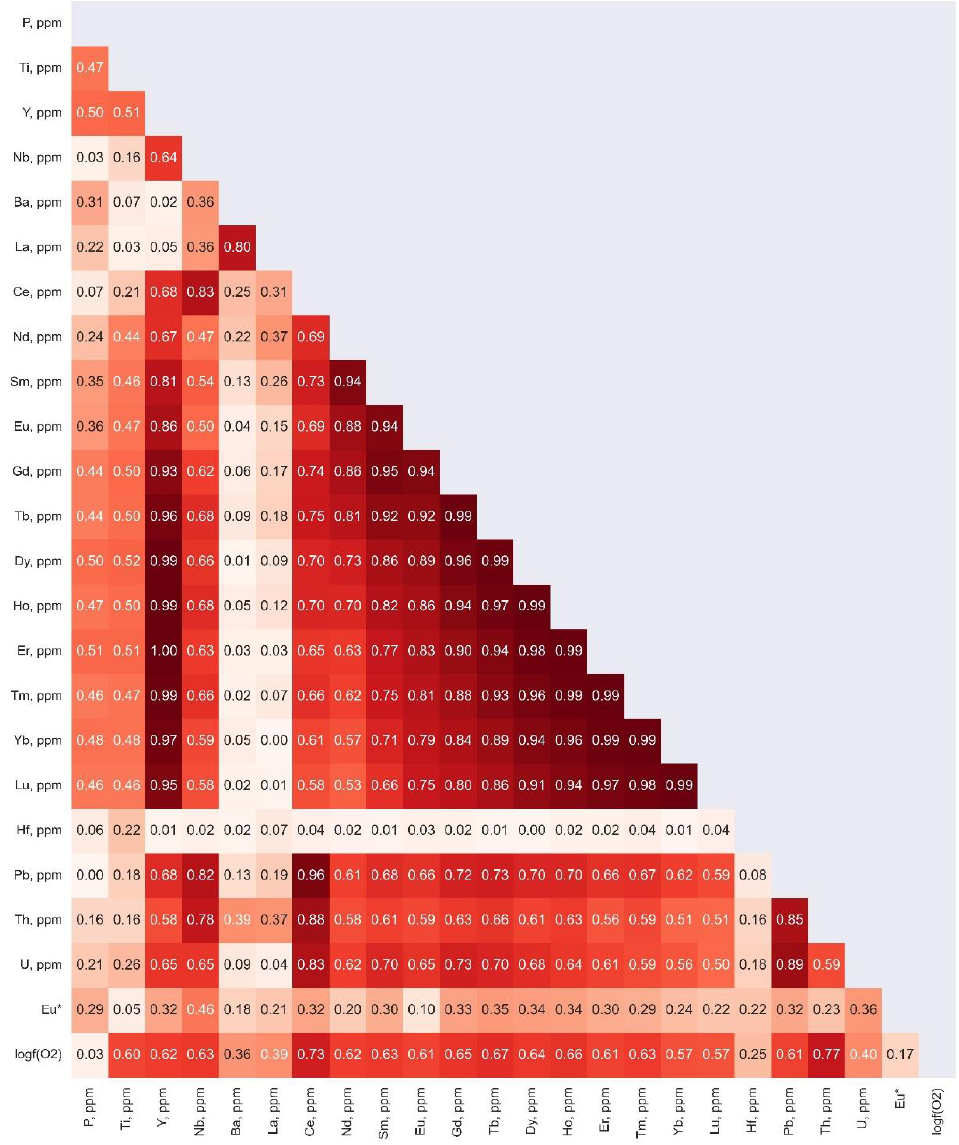
Figure 15. Correlation matrix between different element compositions, Eu anomaly and calculated fO2 for the Timok zircon dataset .